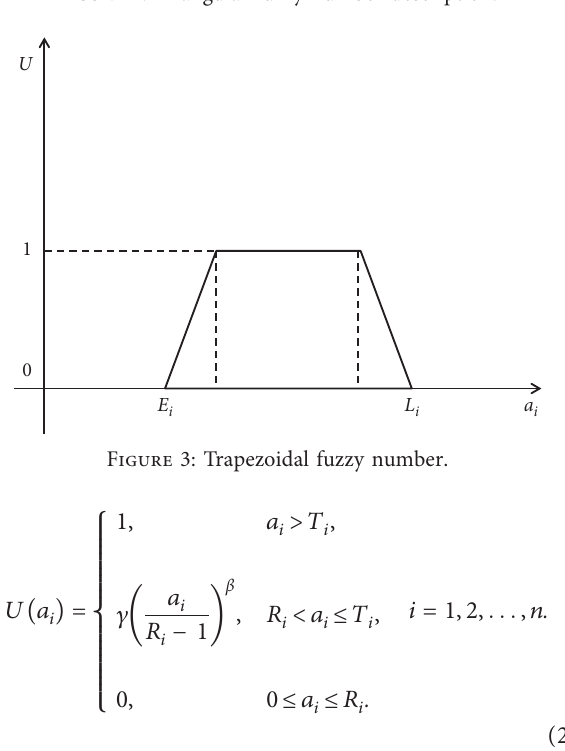
Figure 2: Triangular fuzzy number description.